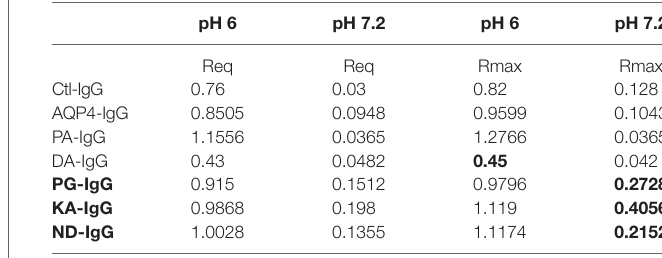
Binding of antibodies to mouse FcRn at an IgG concentration of 6 µg/ml. Binding is shown at equilibrium response R eq or as the maximum binding signal R max . Binding was tested at pH 6 and pH 7.2. All antibodies show equal binding at pH 6, except antibody DA-IgG, which has lower binding. Antibodies with enhanced binding at pH 7.2 (ND- IgG, PG-IgG, and KA-IgG) are shown in bold. Experiments were performed three times for each antibody at pH 6 and pH 7.2 and representatives are shown for each antibody.